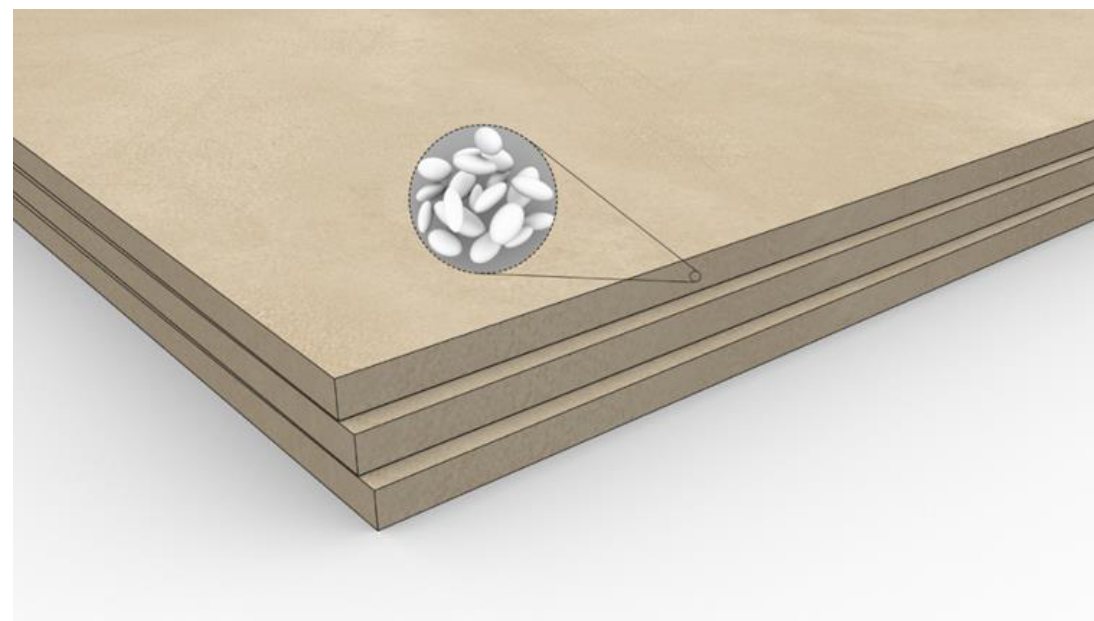
Figure 16. Micronal ® PCM-integrated gypsum wallboard. This figure was redrawn based on [140].